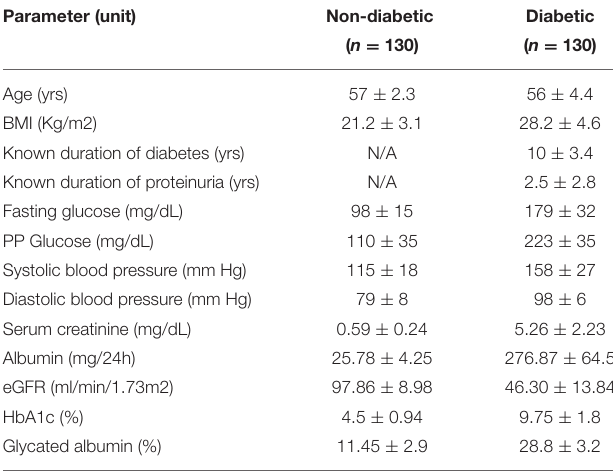
TABLE 1 | Clinical characteristics of the study subjects with and without diabetes.